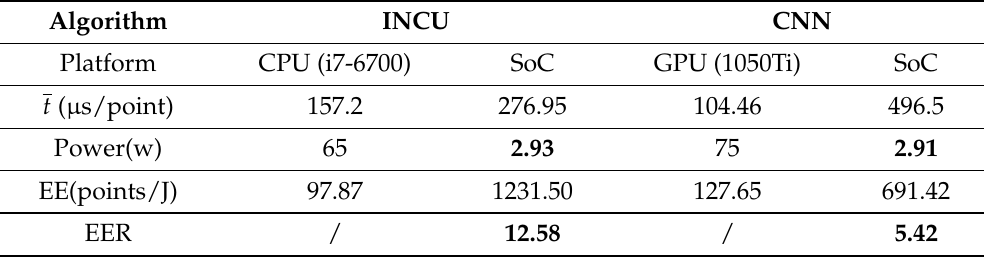
Table 5. Performance comparisons of the SoC platform and the CPU/GPU platform.